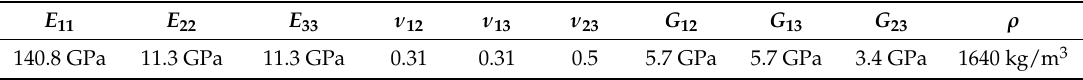
Table 2. Engineering constants of the unidirectional prepreg.